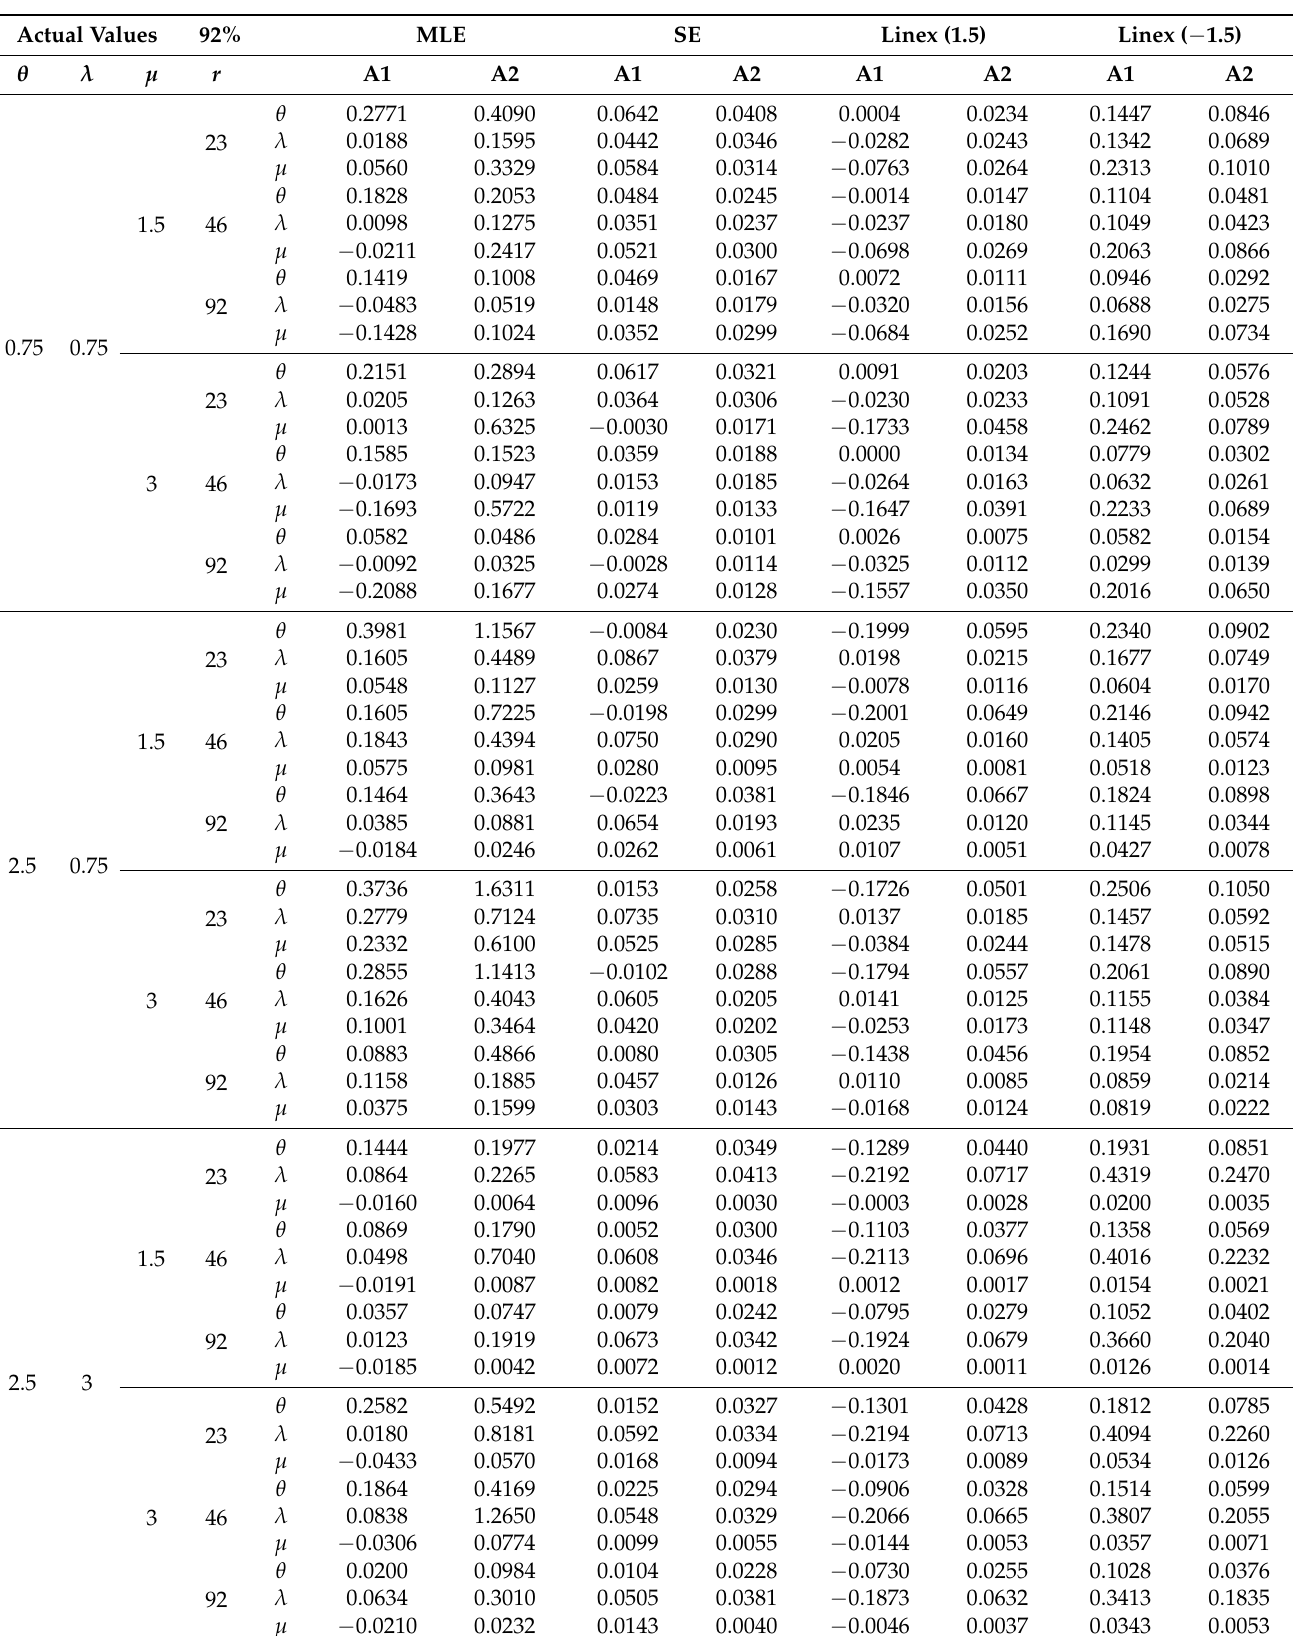
Table 3. MLE and Bayesian estimate for TCPWE model at Type-II censored sample at